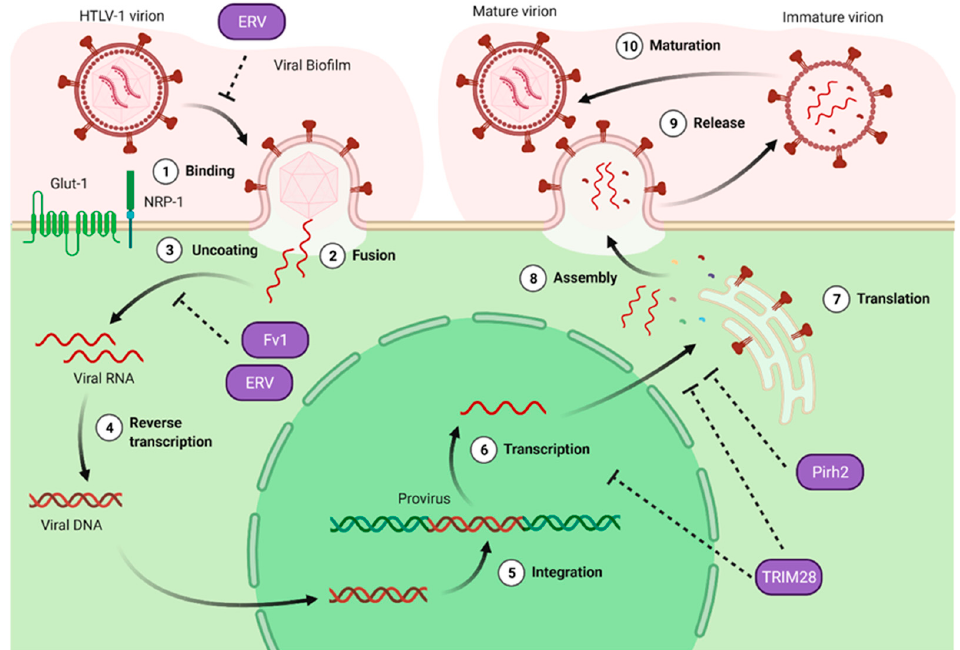
Figure 3. Hints for potential new factors able to restrict the HTLV-1 replication cycle. New HTLV- 1 restriction factors can be searched by scrutinization of antiviral activities against viruses other than HIV. Among them, Pirh2 and TRIM28 target the Foamy virus transactivator Tas, leading to its degradation and restricting viral expression. Endogenous retroviral sequences (ERV) were found to restrict some exogenous retroviral infections in bats and feline animals, and they are thought to target the early steps of infection by inhibiting entry and uncoating. The uncoating step is also targeted by Fv1, a restriction factor identified in several